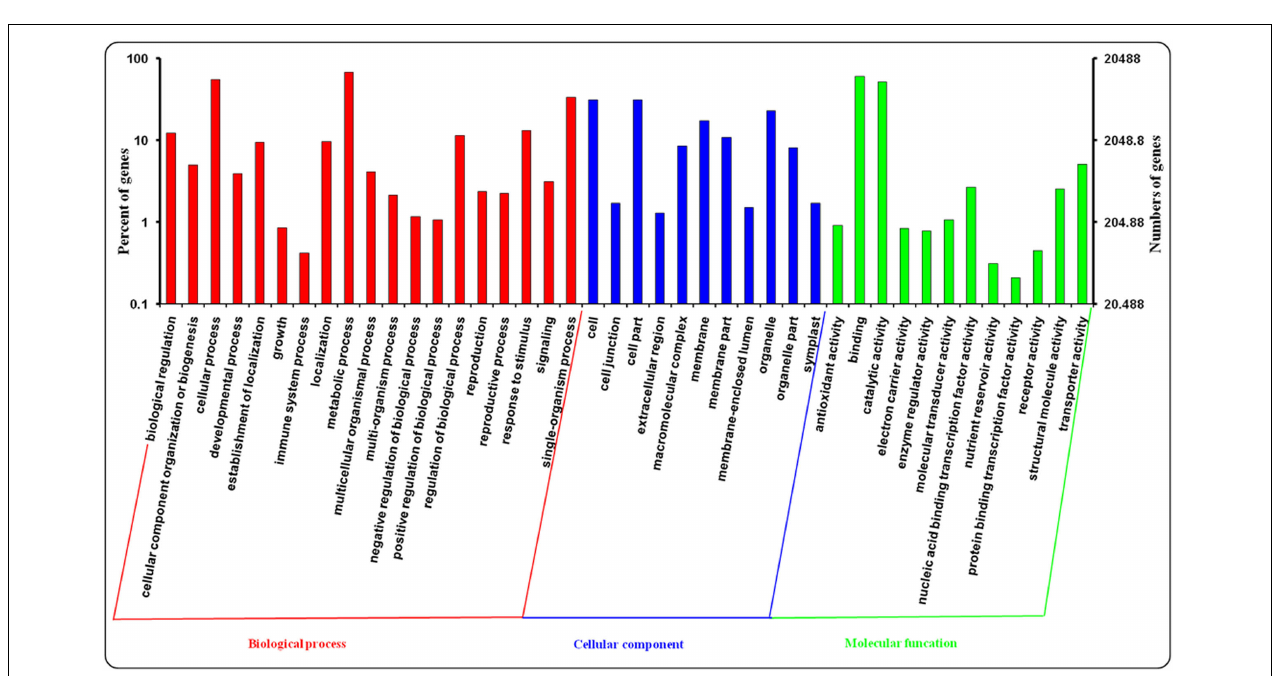
FIGURE 4 | Gene ontology (GO) assignments for leaves and roots transcriptome of A. bidentata .